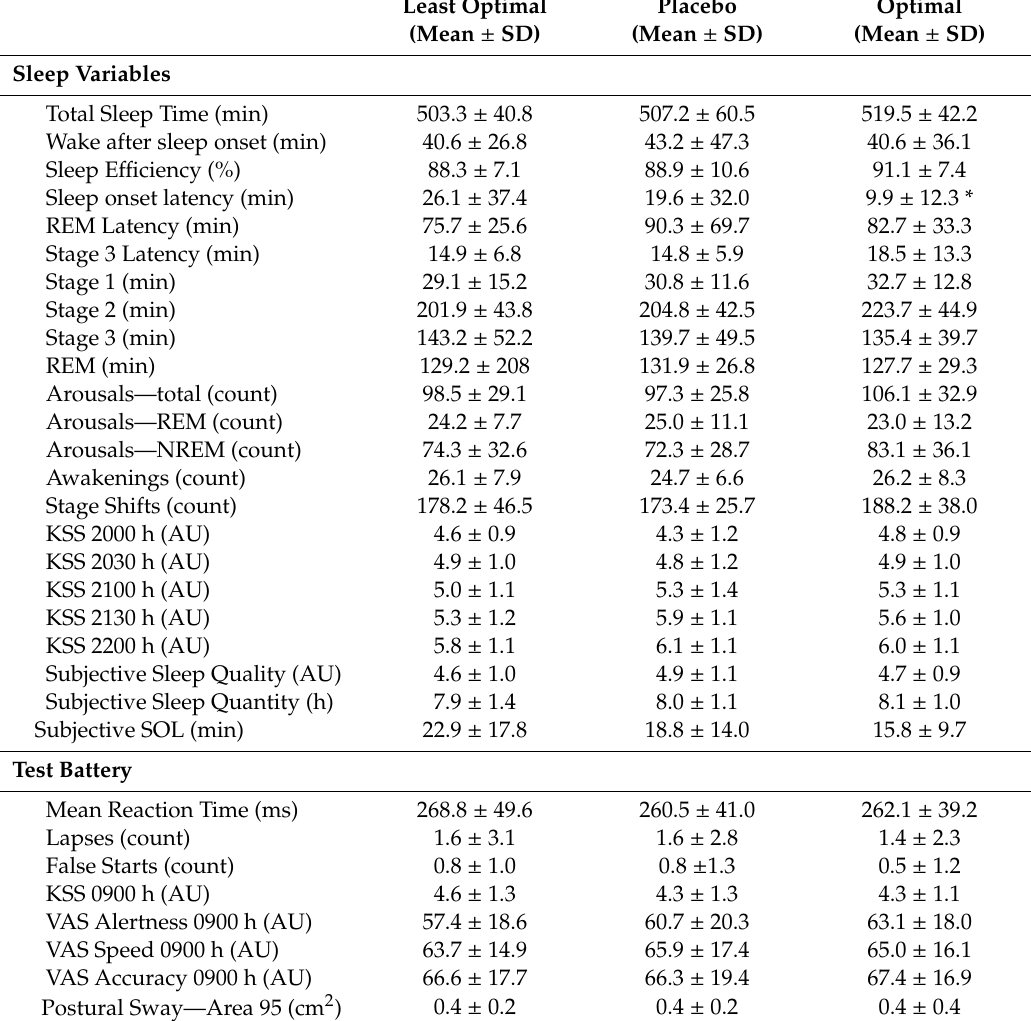
Table 1. Objective and subjective sleep variables and test battery results for least optimal, placebo, and optimal nutritional combinations (mean ± standard deviation